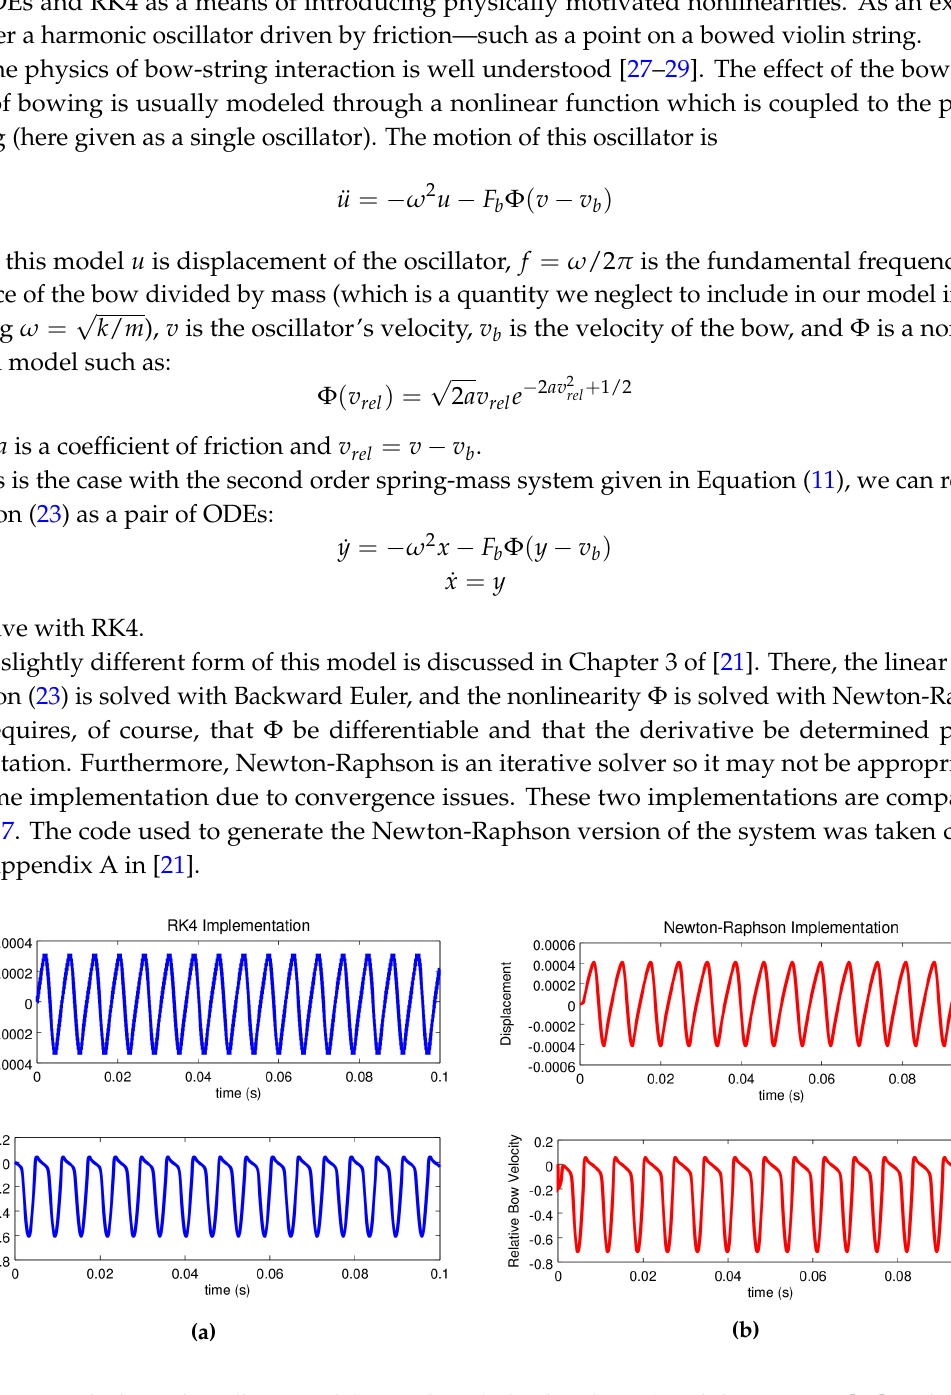
Figure 7. The bowed oscillator model given here (solved with RK4) and that given in [21]. In both implementations, oscillator frequency f = 200, F b = 500, v b = .2 and a = 100. ( a ) The system given in Equation (25) solved using RK4; ( b ) Using Newton-Raphson and Backward Euler to solve Equation